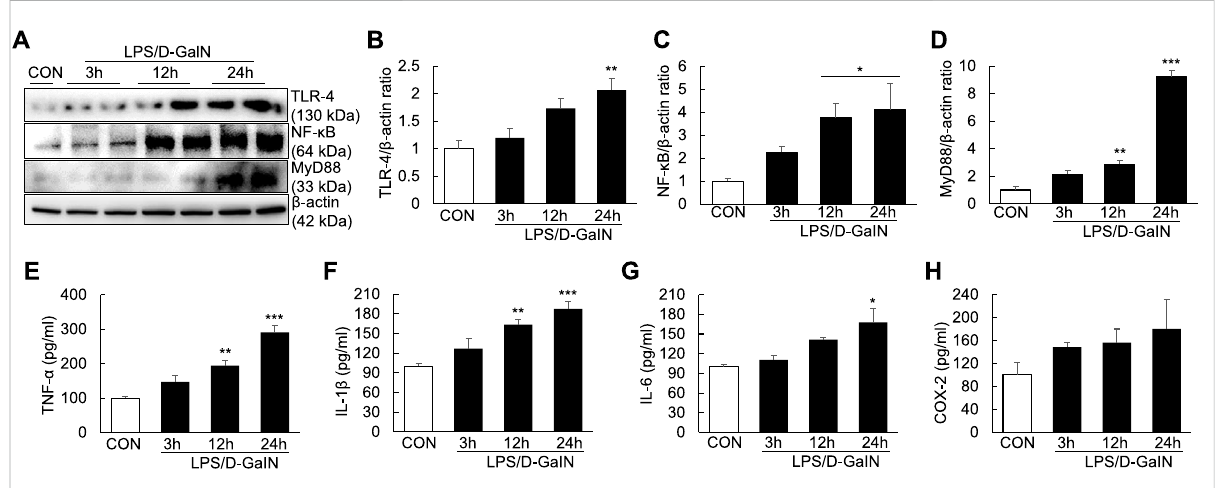
FIGURE 2 Expression of TLR-4/NF- κ B signaling molecules and proin fl ammatory cytokines in the LPS/D-GaIN-induced ALF mouse model. LPS (10 μ g/kg) and D-GalN (600 mg/kg) were administered intraperitoneally (i.p.) to BALB/c mice for 3, 12, and 24 h. We examined TLR-4, NF- κ Band MyD88 levels in the liver using western blotting (A – D) . The levels of proin fl ammatory cytokines (TNF- α , IL-1 β , and IL-6) and COX-2 in the serum were determined using ELISA (E – H) ( n = 3). * p < 0.05, ** p < 0.01, *** p < 0.001 vs.